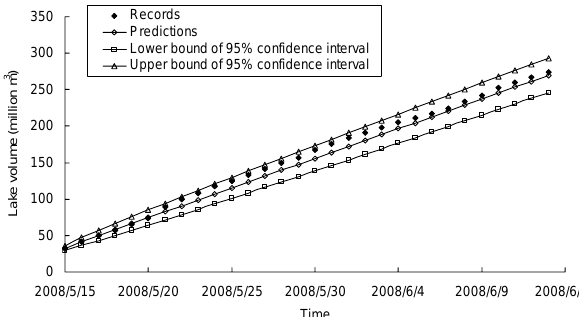
Fig. 5. Predicted inflow rate in stage 1 based on the records before 15 May using the time series method.